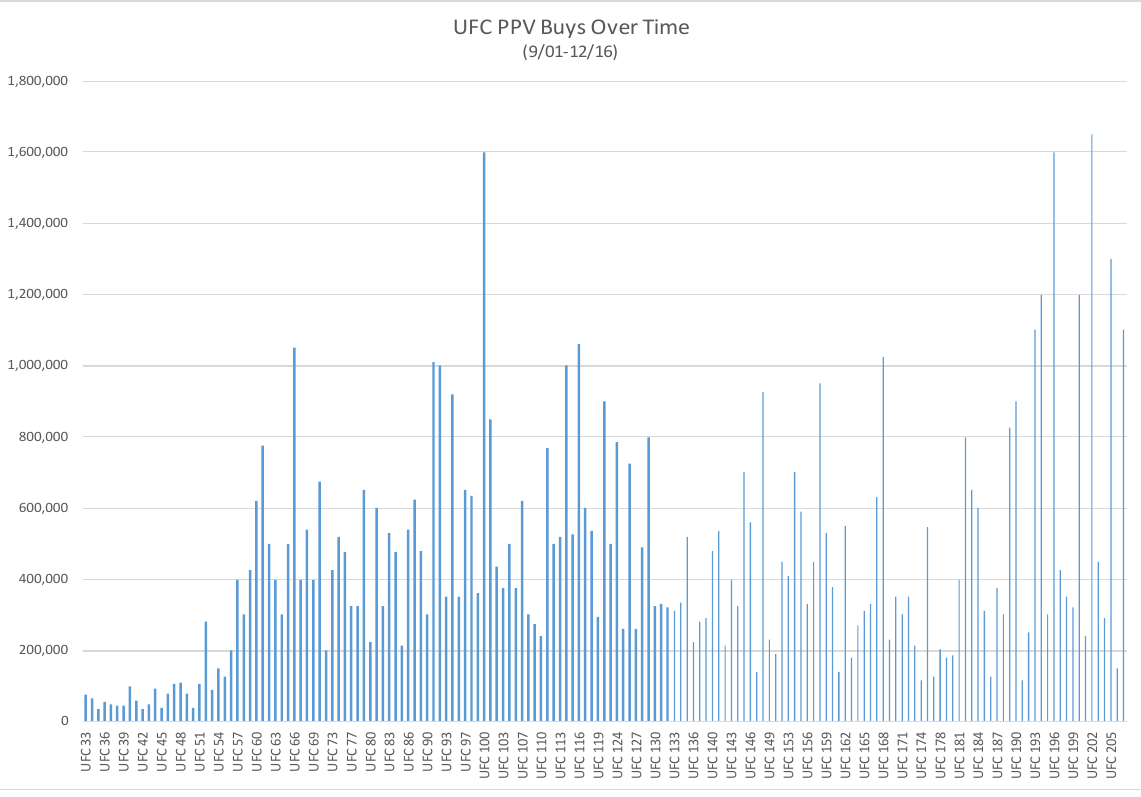
Fig. 2. PPV buys (2001 ‒